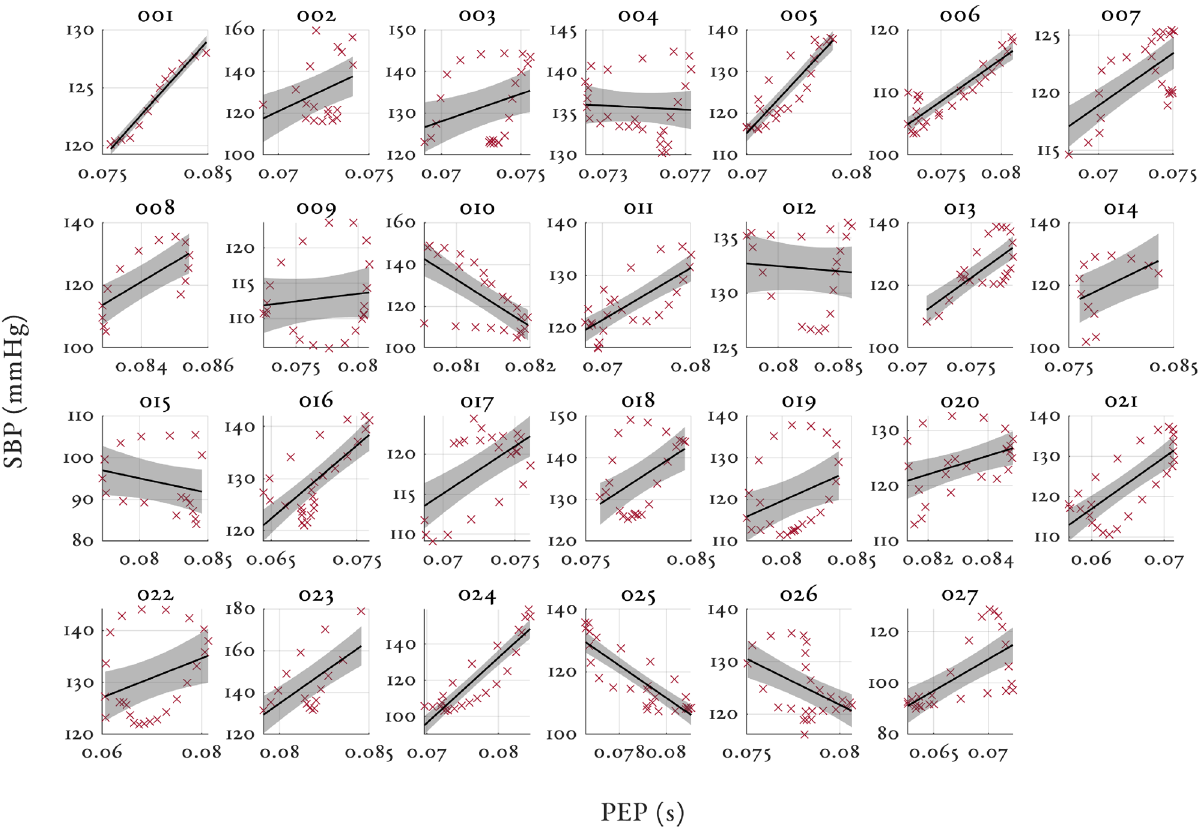
Figure 4. Individual relationships between SBP (mmHg) and PEP (s) for all volunteers in the study. The 95% confidence intervals are shown by the shaded region for each volunteer. Please note again the wide variation in y-axis